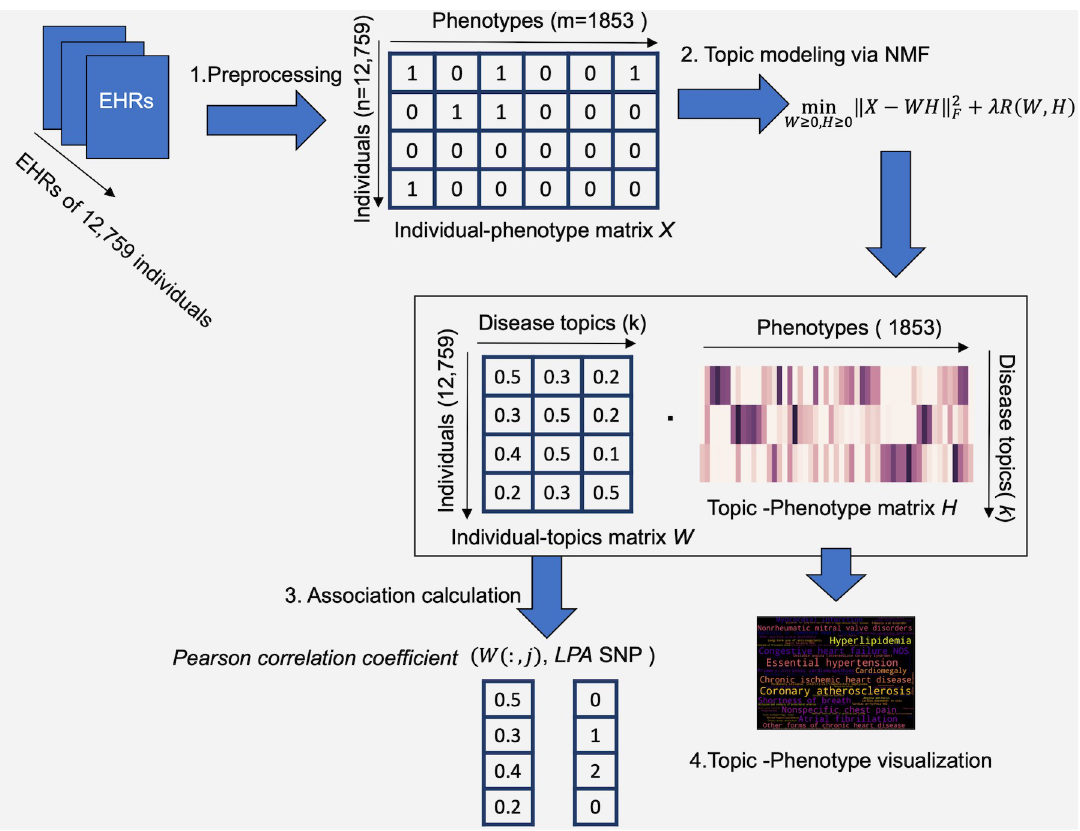
Fig 1. Illustration of topic modeling on EHRs using